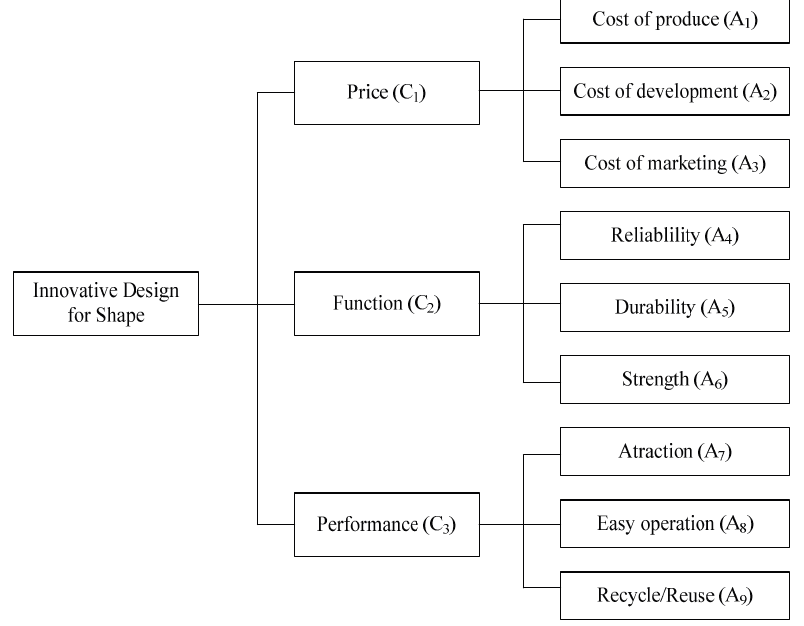
Figure 3. The hierarchical structure of AHP.